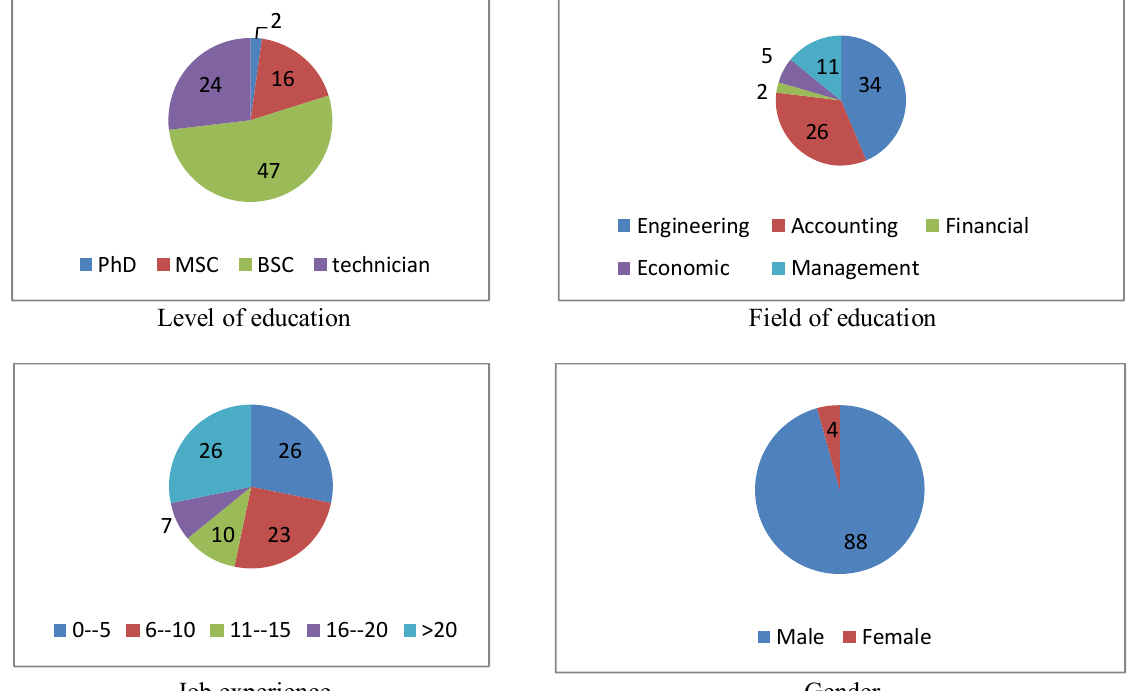
Fig. 3. Personal characteristics of the